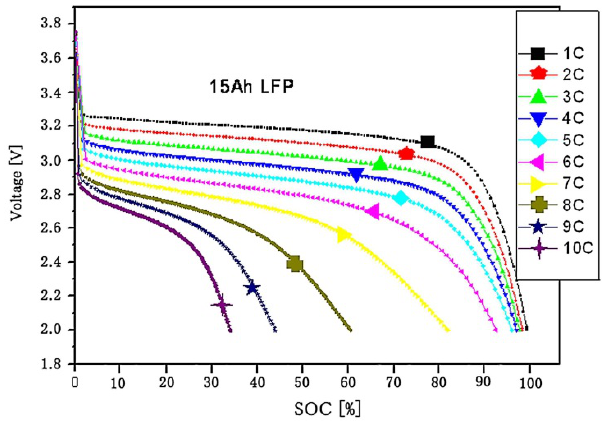
Figure 2. Battery capacity ratios under different discharge